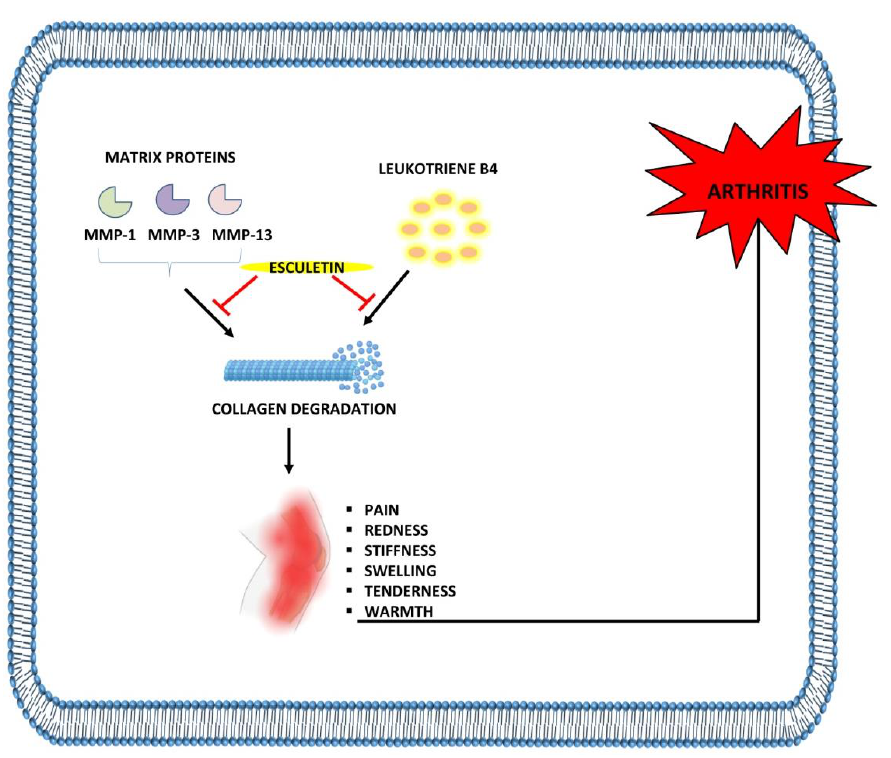
Figure 5. Anti-arthritic effects of esculetin: Esculetin inhibits the degradation of cartilage through the suppression of MMP-1, MMP-3, MMP-13, and leukotriene B4, leading to the inhibition of arthritis. (cid:97) : inhibition. Table 4. Mechanism and function of esculetin in treatment of arthritis.